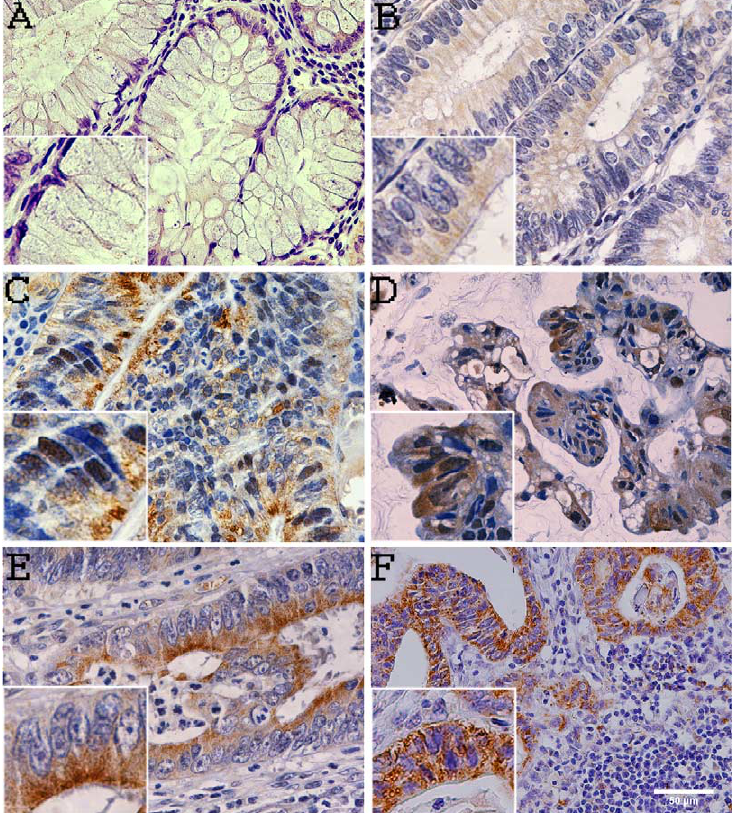
Fig. 4. Ski expression in human colorectal cancer. (A) Normal colon mucosa with negative Ski expression. (B) Weak Ski staining in an adenoma. (C) Adenoma with high grade dysplasia showing intense cytoplasmic and nuclear expression of Ski. (D) Cytoplasmic and nuclear Ski expression in an invasive mucinous carcinoma. (E, F) Comparable cytoplasmic expression levels of Ski in a case of nodal metastasis (F) compared to the corresponding primary tumor (E) (400 × magnification). Inserts in lower left corner show the subcellular localization of immunostaining in each case at higher magnification (2 × original objects). Bar corresponds to 50